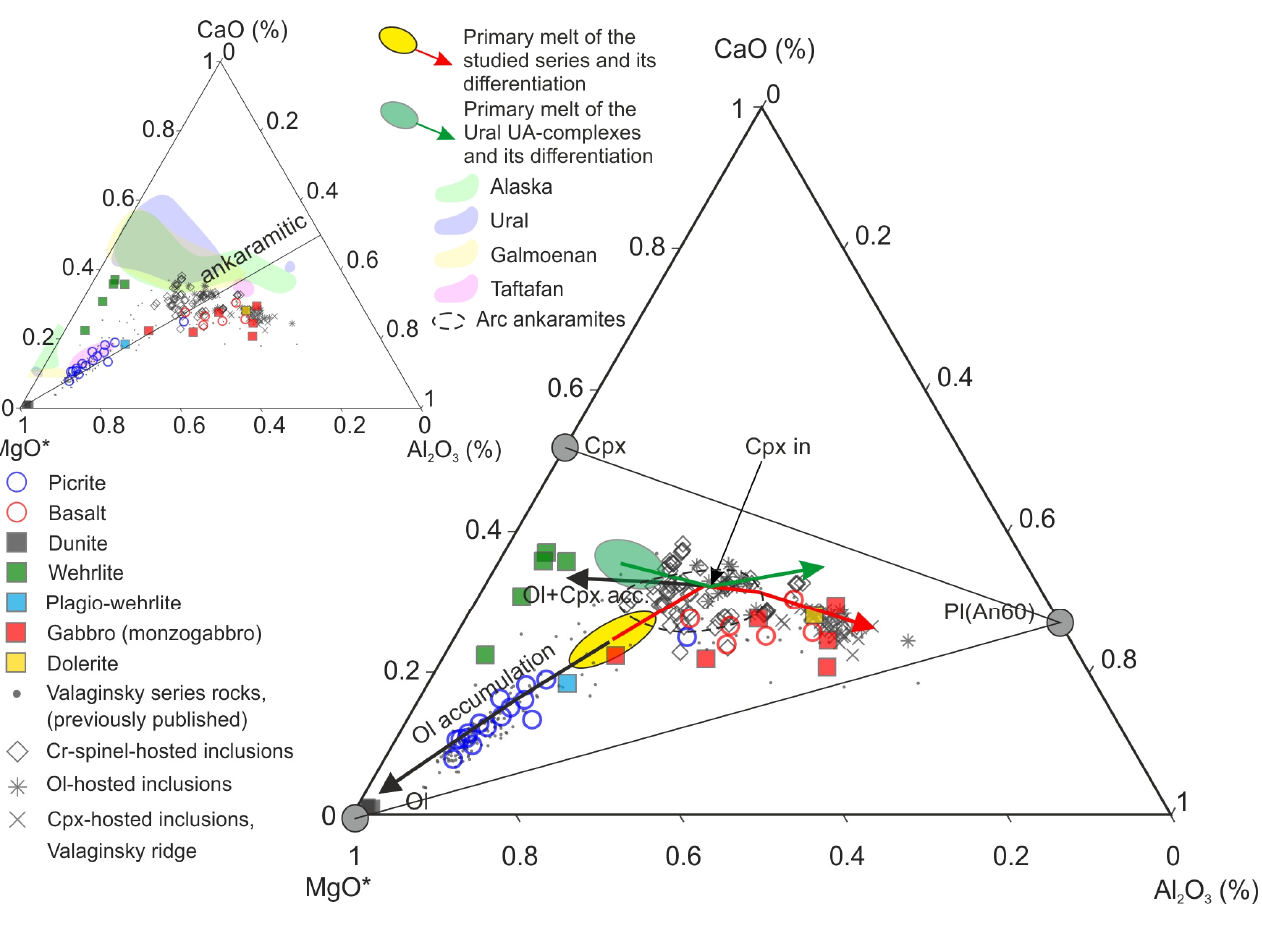
Figure 15. Compositions of the studied rocks plotted in MgO*-CaO-Al 2 O 3 coordinates, where MgO* = MgO + 0.55FeO [15,19,77]. Primary melt for our series is estimated as average between compositions of the chromite-hosted melt inclusions and the estimation of Kamenetsky et al. (1995). Primary melt of the Ural UA-complexes and its differentiation trend are from [15,19]. Data for melt inclusions are from this study and [54,61]. Data sources for the fields of the UA-complexes worldwide are as in Figure 10. Data sources for the field of arc ankaramites are from [74,81,103].